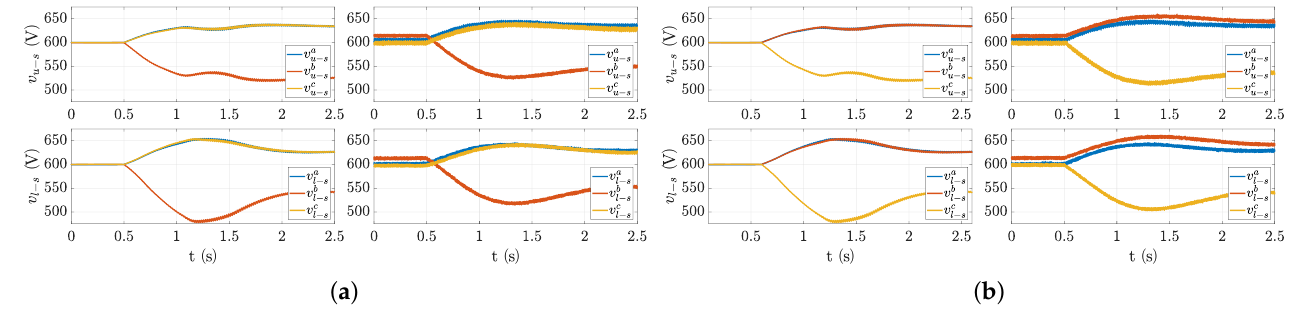
Figure 13. Simulation ( left ) and experimental ( right ) results, showing capacitors (arm cells) voltage during a step from 0 J (normal operation) to 120 J is applied to the energy difference between phase A and phase B ( a ) and between phase A and C ( b ).